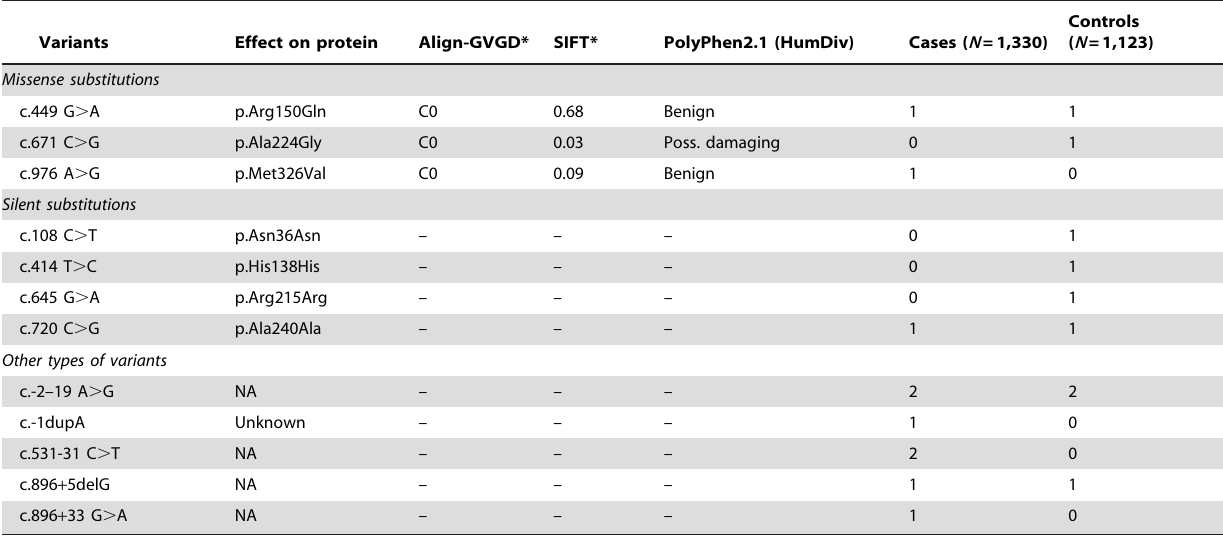
Table 1. Rare genetic variants of RAD51 identified in the BCFR.